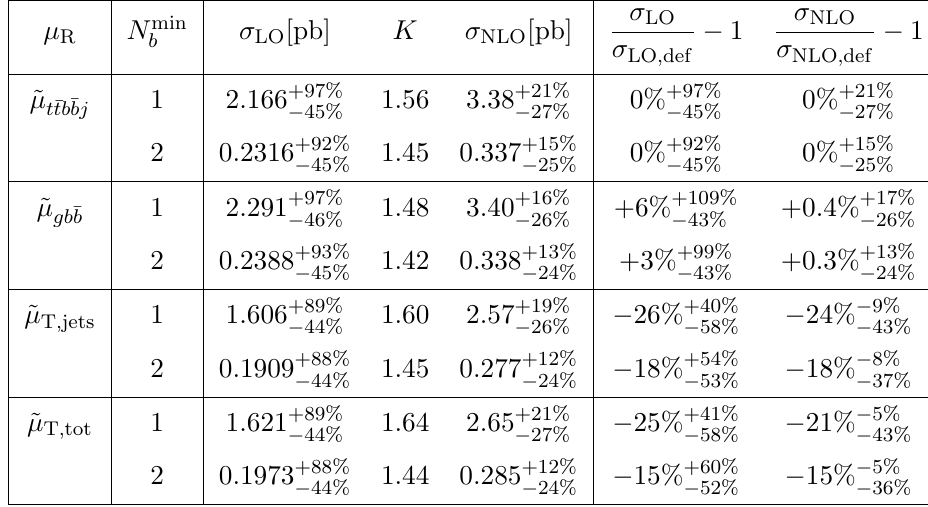
Table 5. Cross sections at LO and NLO for pp and ttbbj ( N min = 2) phase spaces. Similar predictions and variations as in table 4 for the case of b the aligned central scales de(cid:12)ned in